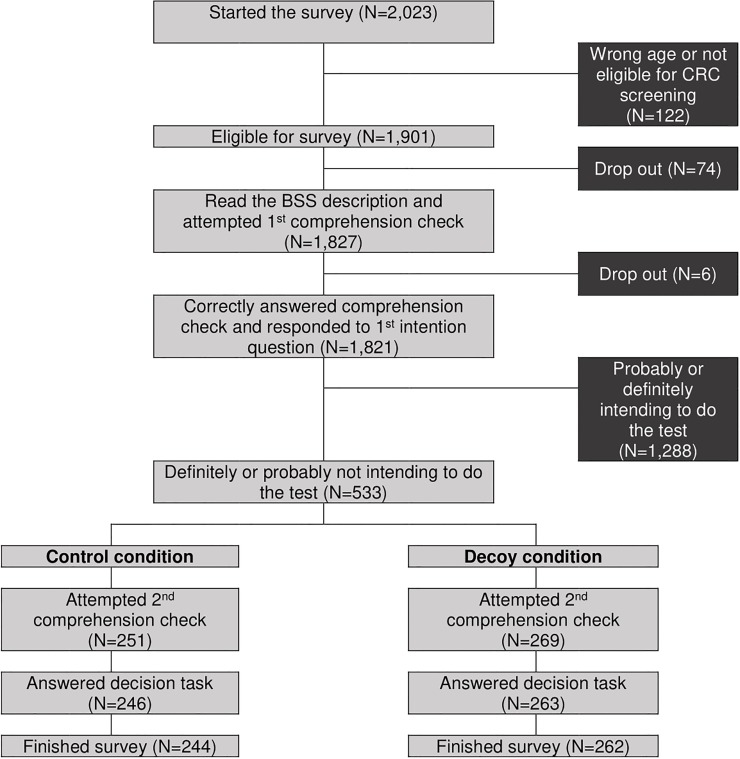
Flow though Study 1.